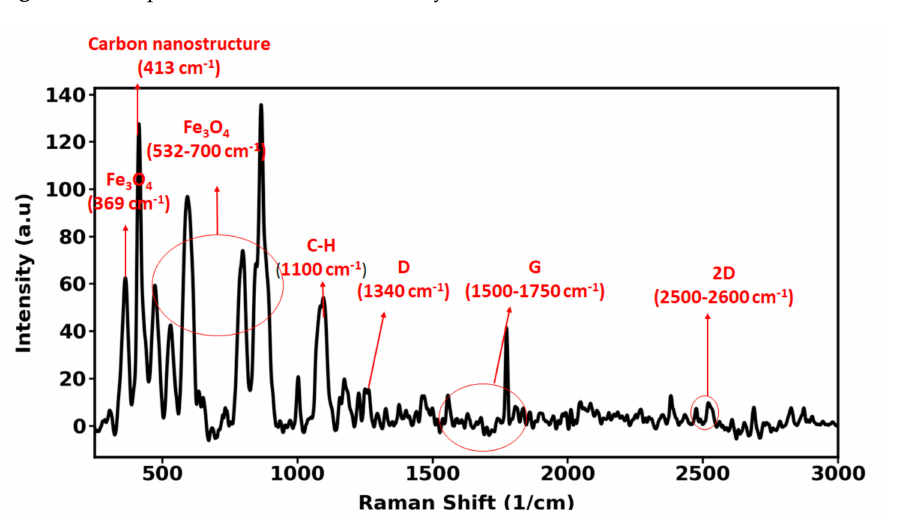
Figure 3. Raman spectroscopy of iron-carbon